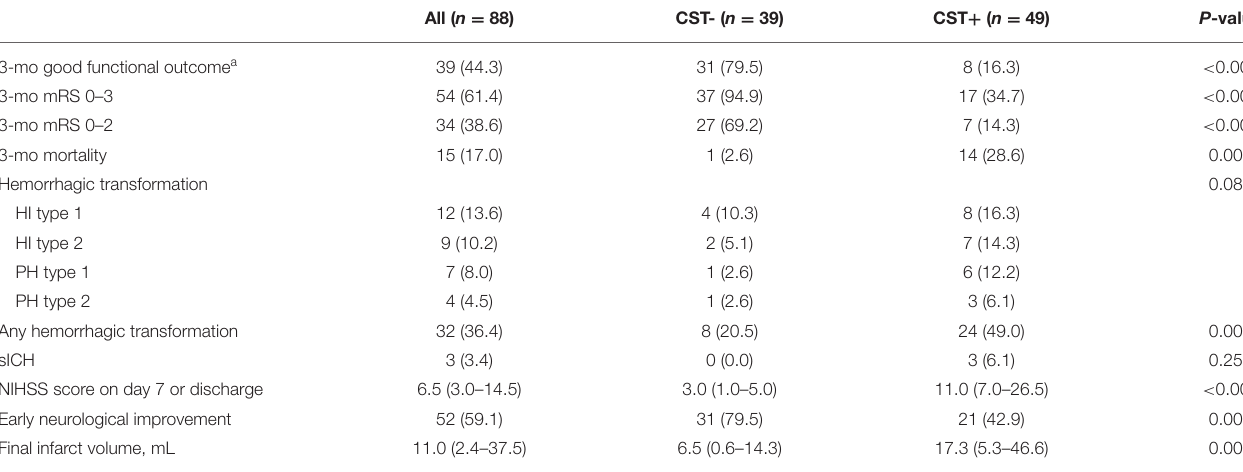
TABLE 2 | Patient outcomes.